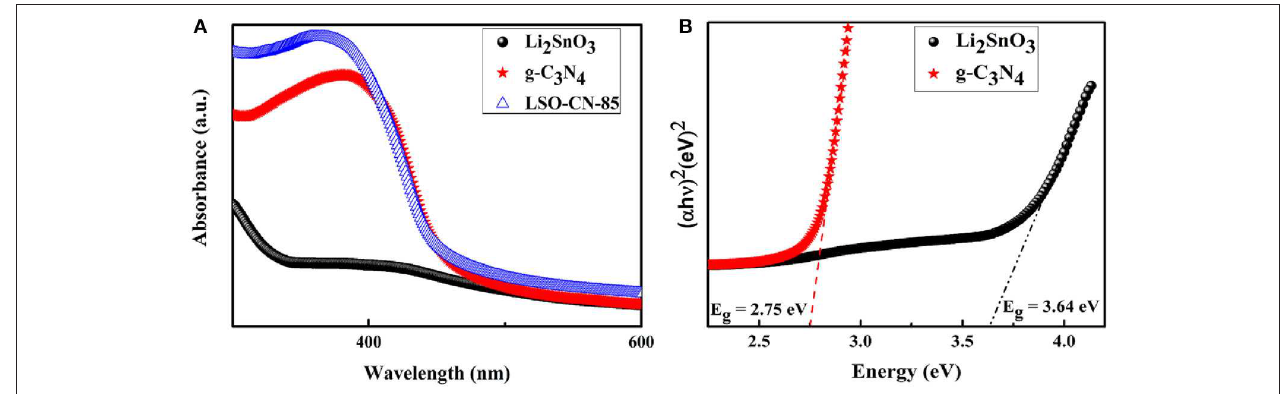
FIGURE 5 | (A) Photocatalytic degradation of RhB with as-synthesized samples under visible light ( λ ≥ 420nm); (B) The pseudo-first order kinetic fitting of the photodegradation of RhB; (C) The fitted kinetic constants for RhB photodegradation; (D) Cycling experiments of LSO-CN-85 for RhB photodegradation.